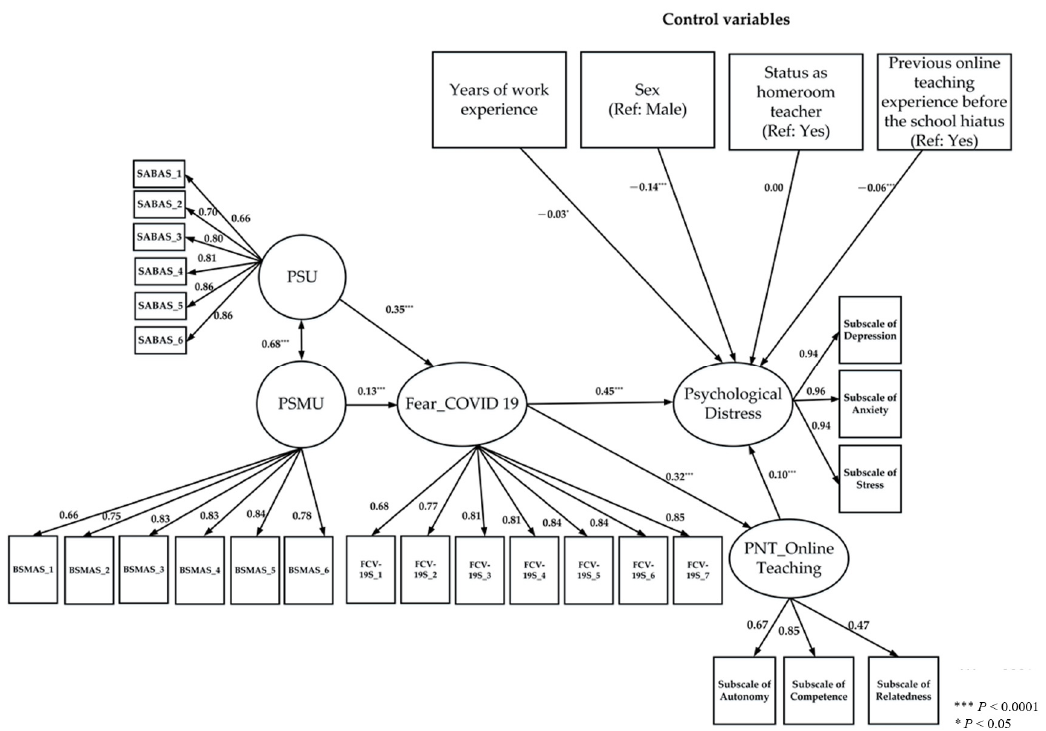
Figure 2. Structure equation model, including path